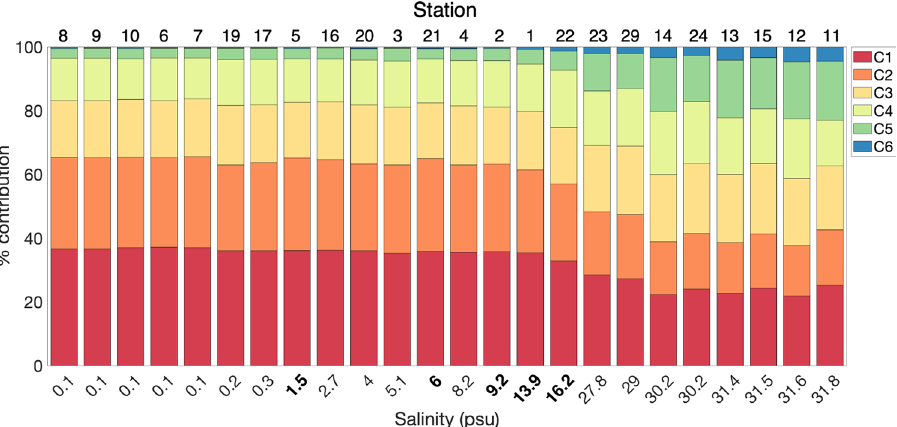
Figure 6. PARAFAC component percent contribution ordered by salinity, with station number indicated above each bar plot. Bolded salinities correspond to stations sampled along a same-day transect of salinity on May 30, 2019, on the southern edge of the Yukon River